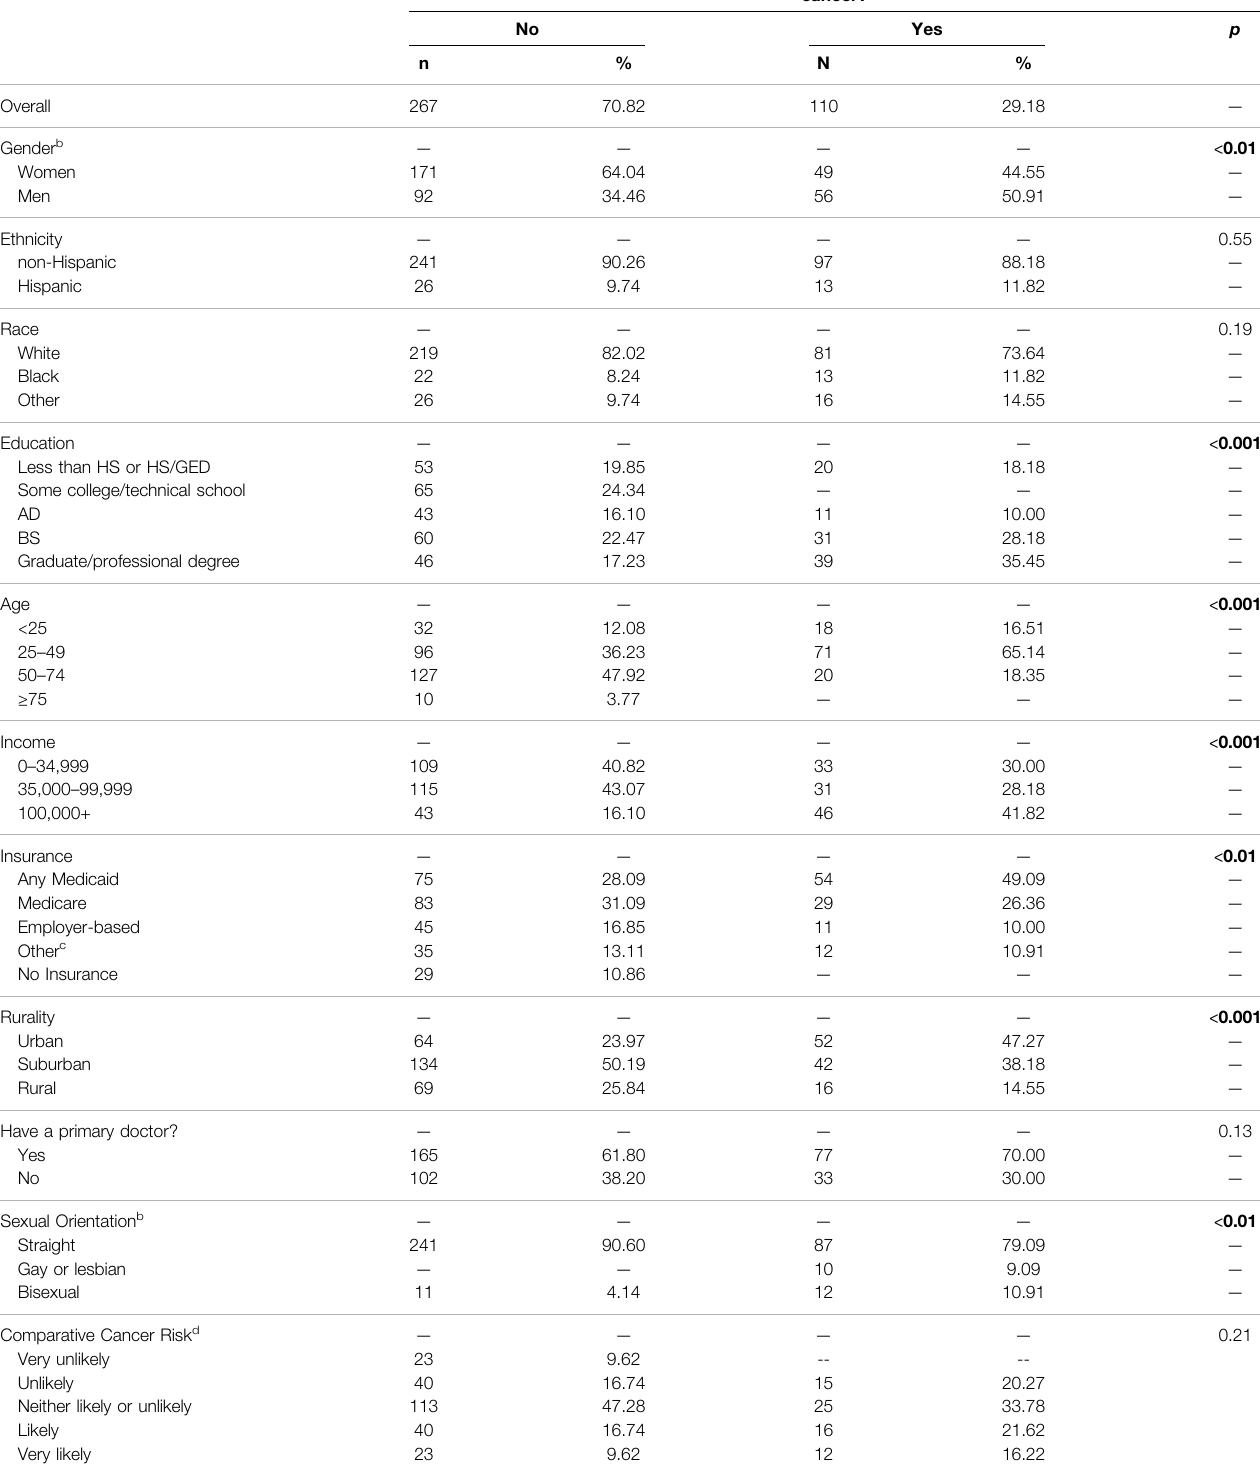
TABLE 2 | Descriptive characteristics of those how have and have not received a genetic test for cancer risk.